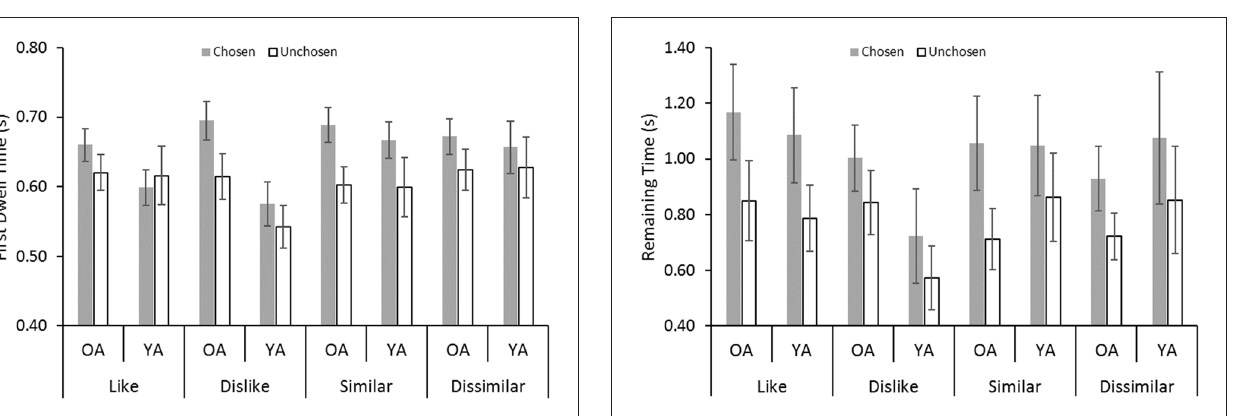
stimulus than at an unchosen stimulus ( F ( 1,32 ) = 14.67, p < 0.001, η 2 = 0.31). No significant effect of age was found ( F ( 1,32 ) = 0.96, p